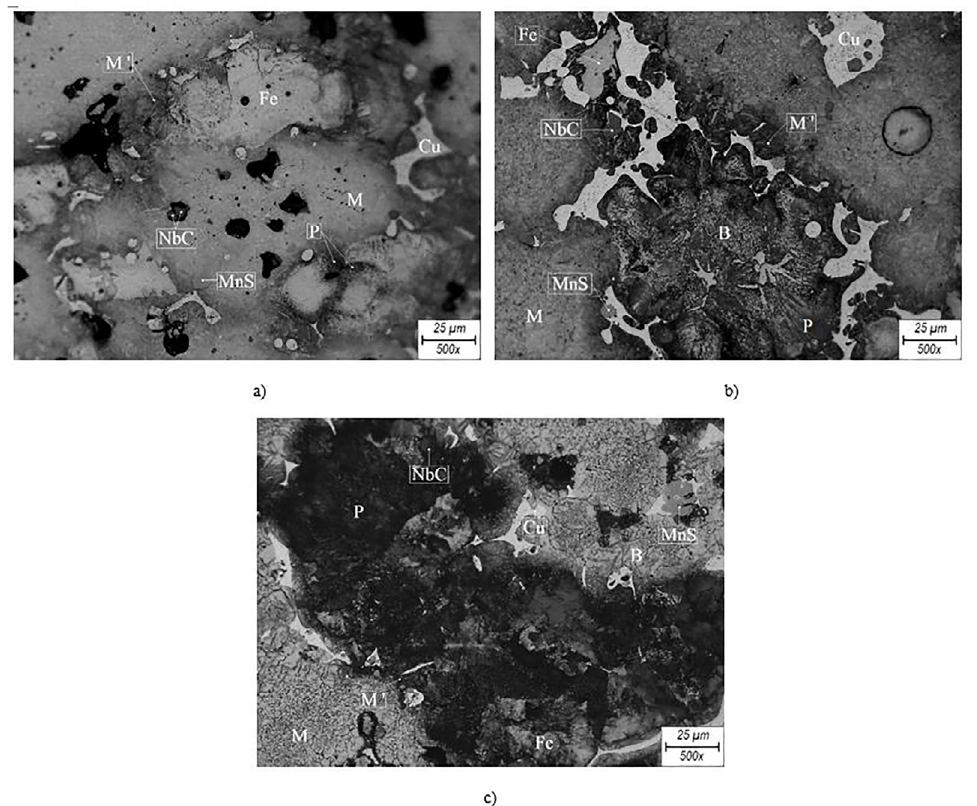
Figure 5. Optical micrographs of a) Alloy 1 (AISI M3:2 mixture) and b) Alloy 2 (AISI M2 mixture) air quenched and double tempered at 600 ºC, and c) Alloy 3 (AISI D2 mixture) air quenched and double tempered at 500